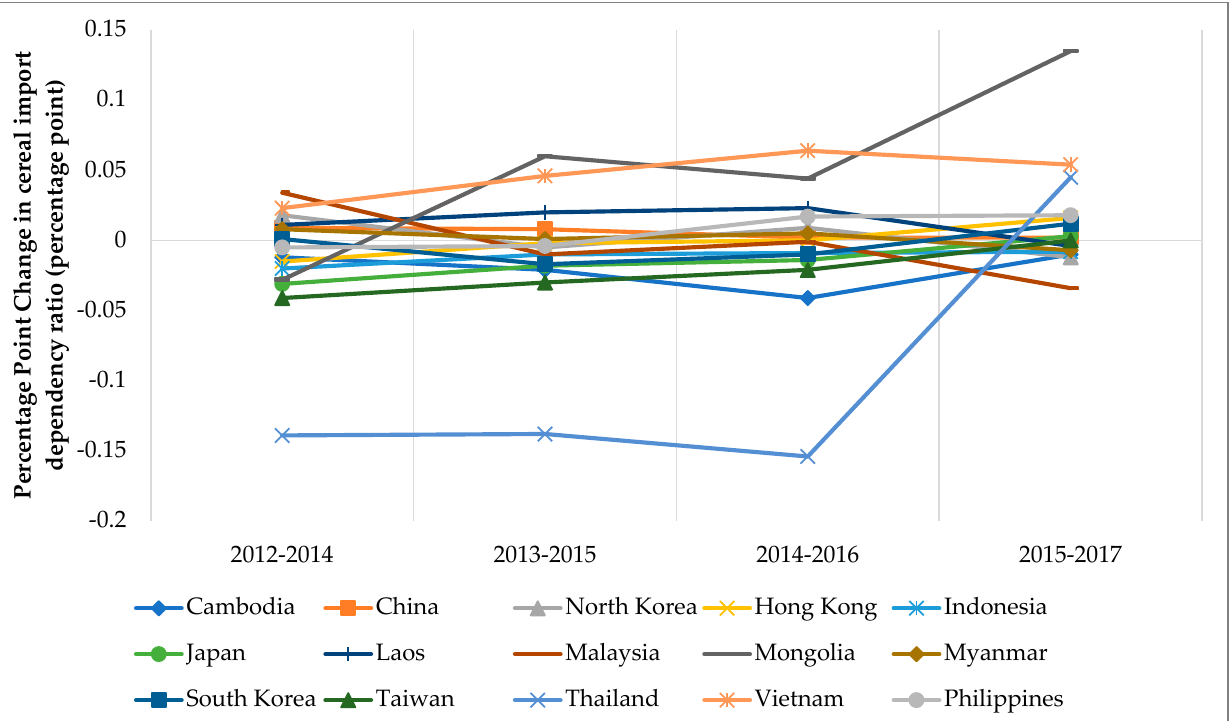
Figure 3. Cereal import dependency ratio for East and Southeast Asian economies in 2017 (Source: data retrieved and adapted from [4]).